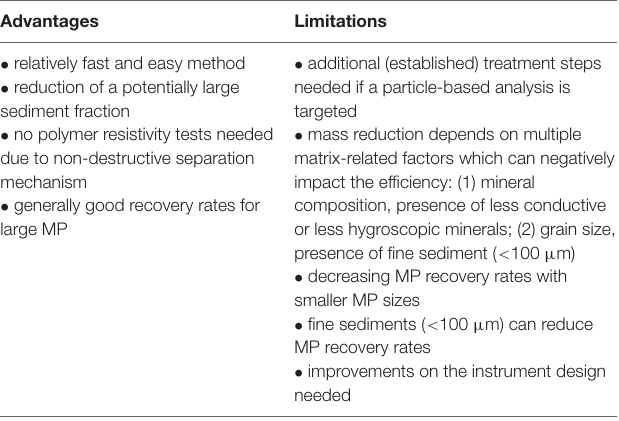
TABLE 2 | Summary of advantages and limitations of electrostatic separation (using the KWS) for MP purification from sediments. Advantages